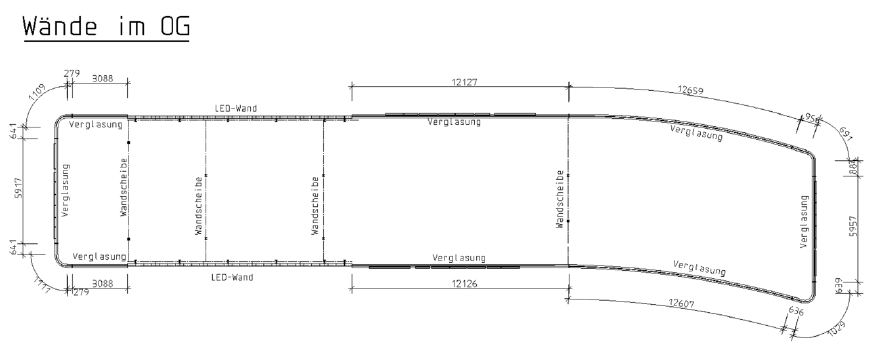
Figure 2: Top view façade on upper floor.